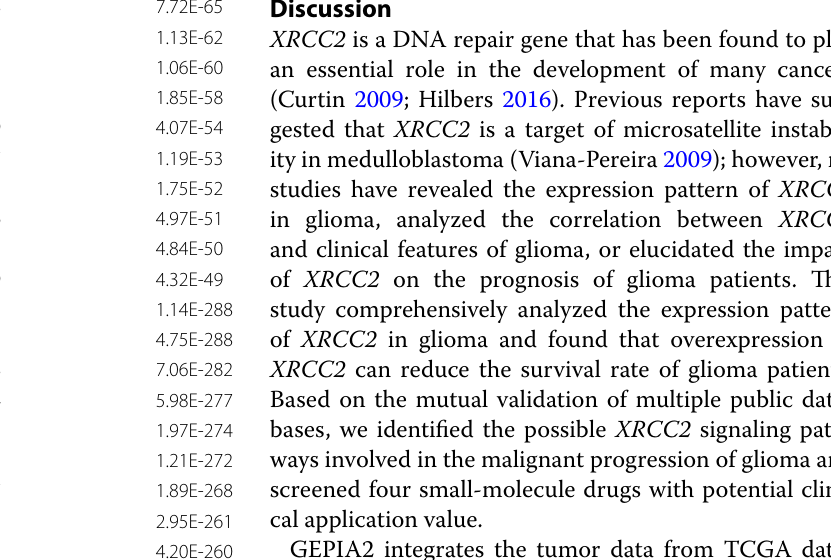
Mismatch repair NES normalized enrichment score, NOM nominal, FDR false discovery rate. Gene sets with NOM P-value < 0.05 and FDR q-value < 0.25 were considered as significantly enriched, NOM nominal, FDR false discovery rate. Table 3 Genes co-expressed with XRCC2 No.